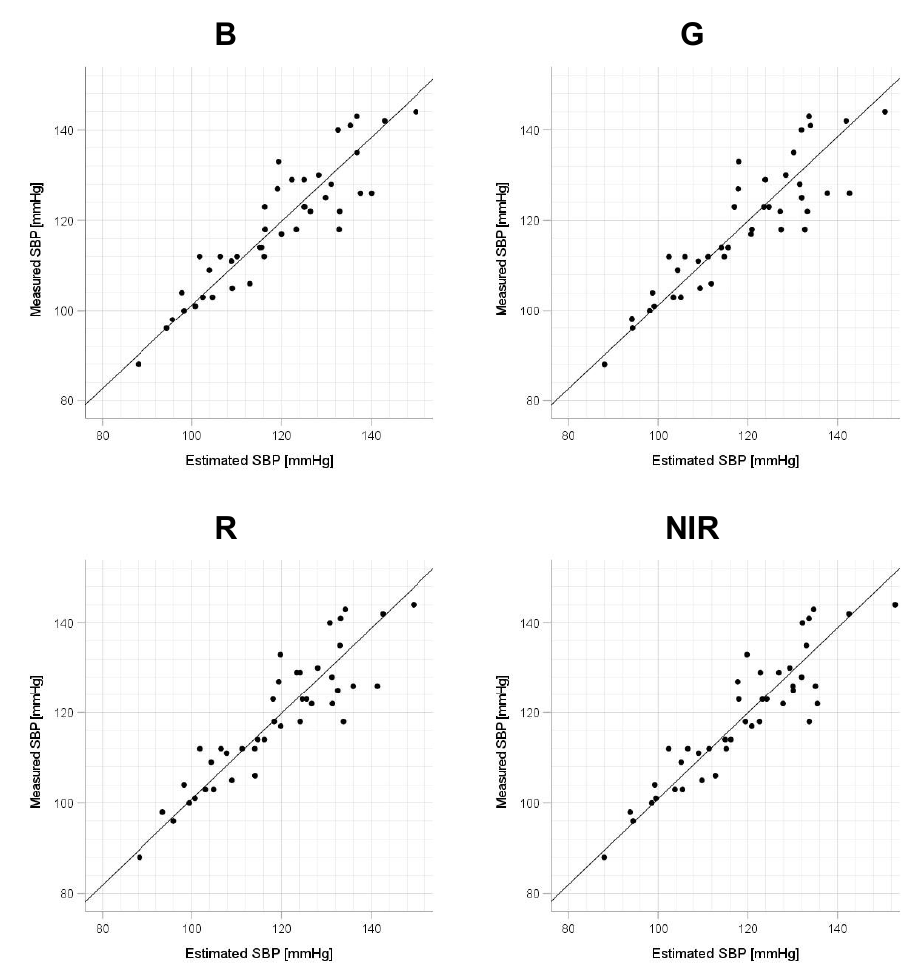
Figure 6. Accuracy of systolic blood pressure (SBP) estimation at each wavelength. Scatterplots of SBP estimated using proposed method and SBP measured with a cuff sphygmomanometer ( N = 42). From left to right, the light source wavelengths are blue (B), green (G), red (R), and near-infrared (NIR). The solid line on each scatterplot is the regression line with geometric mean regression.